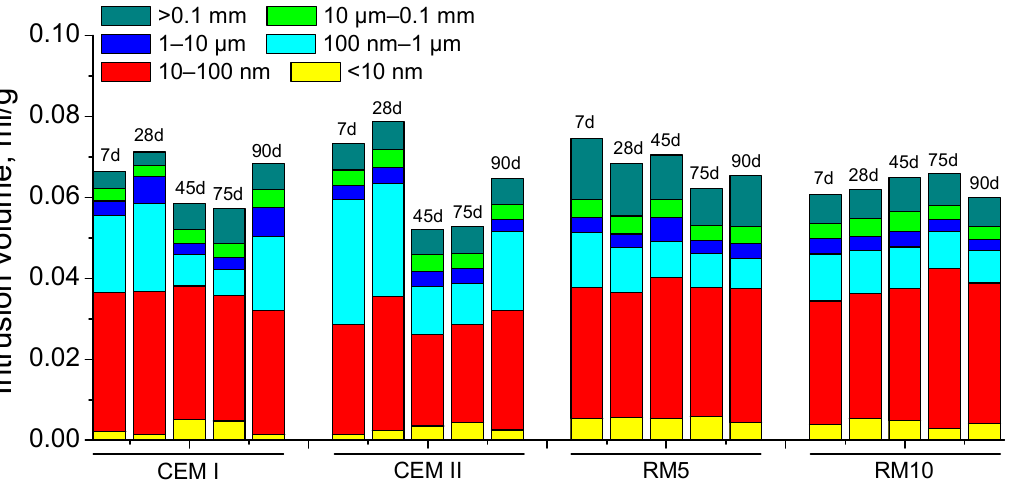
Figure 4. Pore size distributions obtained for CEM I, CEM II, RM5 and RM10 mortars.